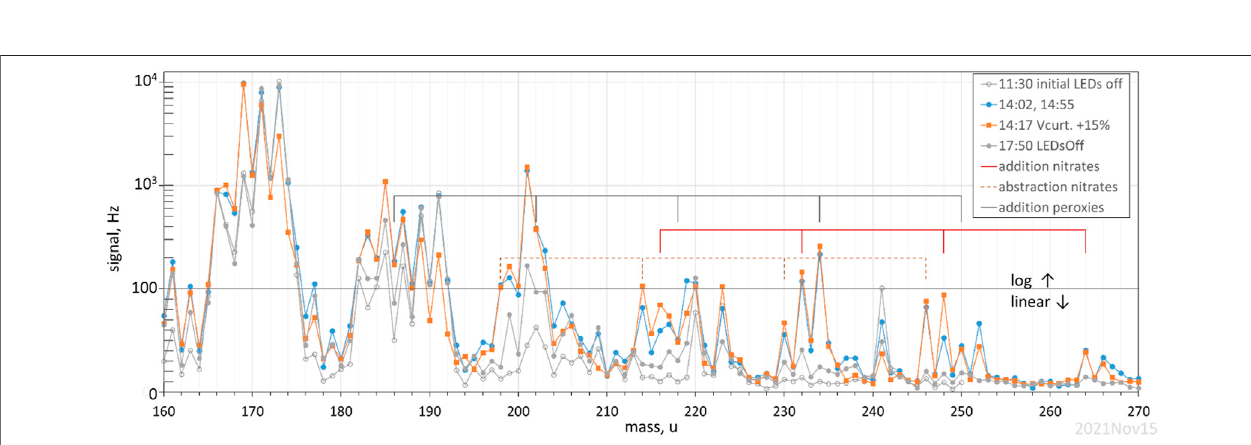
FIGURE 4 | Proton-transfer mass spectra of α -pinene and its photo-oxidation products. α -pinene and HONO were present for all scans, the two scans with the LEDs on are at different curtain voltages. Signal at 220, 223, and 241 u seems to be due to instrument background.